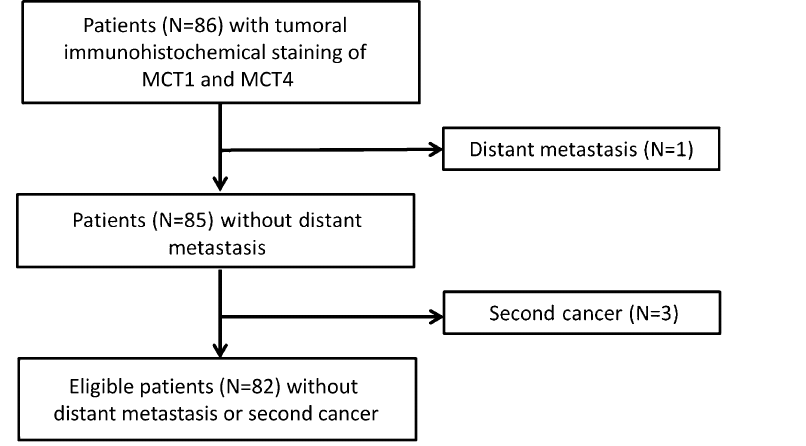
Figure 1. Flowchart for patients eligible for